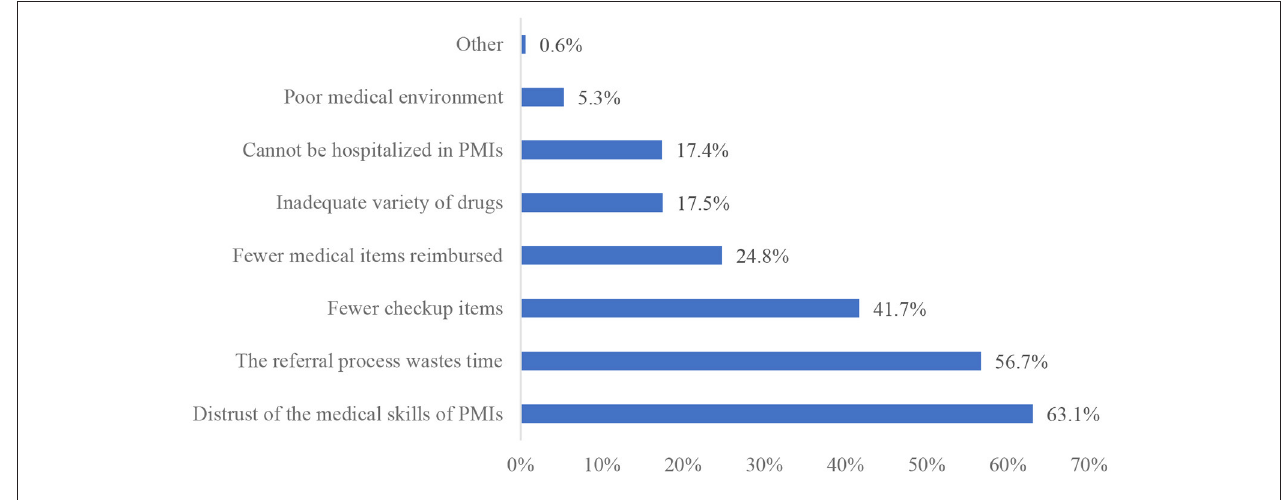
FIGURE 3 | Reasons for patients’ unwillingness for first visit in